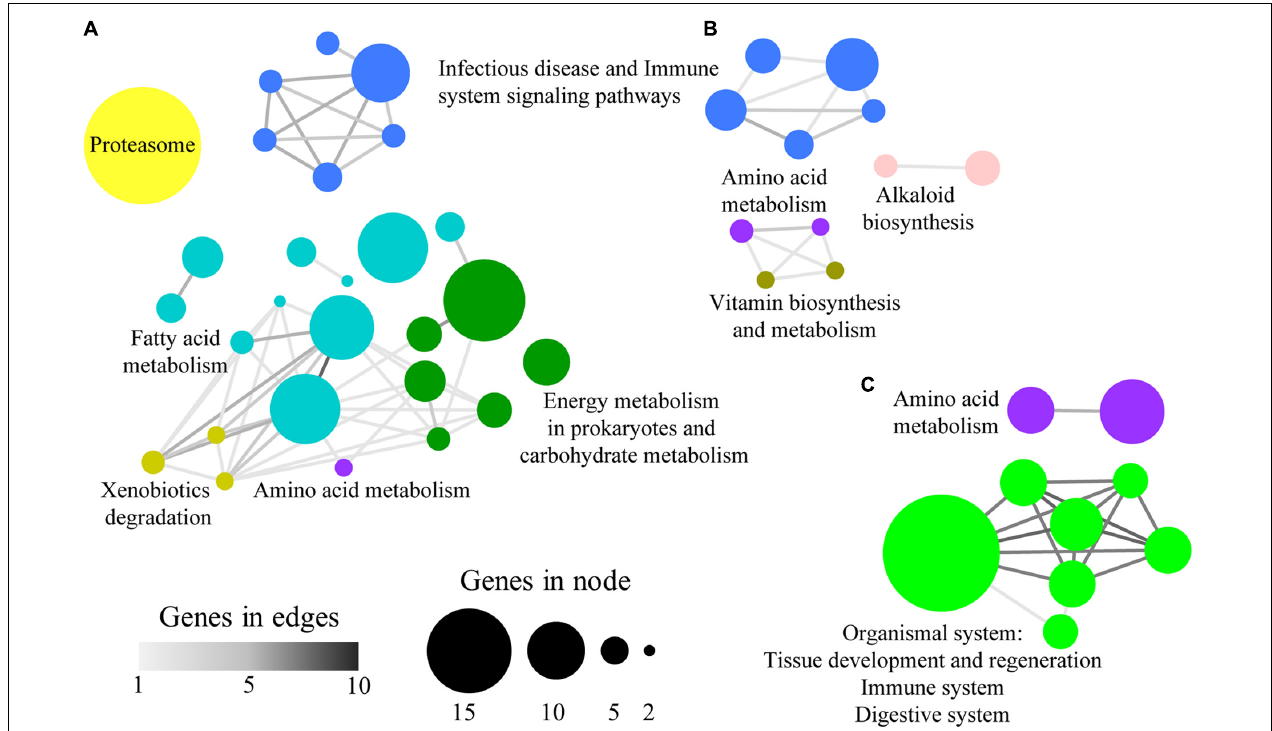
FIGURE 5 | Network layout representing the associations between over-represented KEGG terms according to their shared allocated genes in panels (A) C1 + C3, (B) C2, and (C) C4. Node size represents the number of genes allocated to a specific GO-BP term. Node colours show the representative name of clustered KEGG terms. Edge width represents the number of shared genes between two KEGG